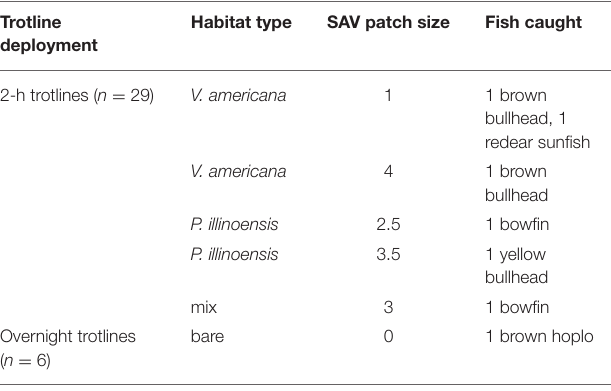
TABLE 2 | All fishes caught on 2-h trotlines and overnight trotlines and the habitat type and SAV patch size in which they were captured. Trotline Habitat deployment